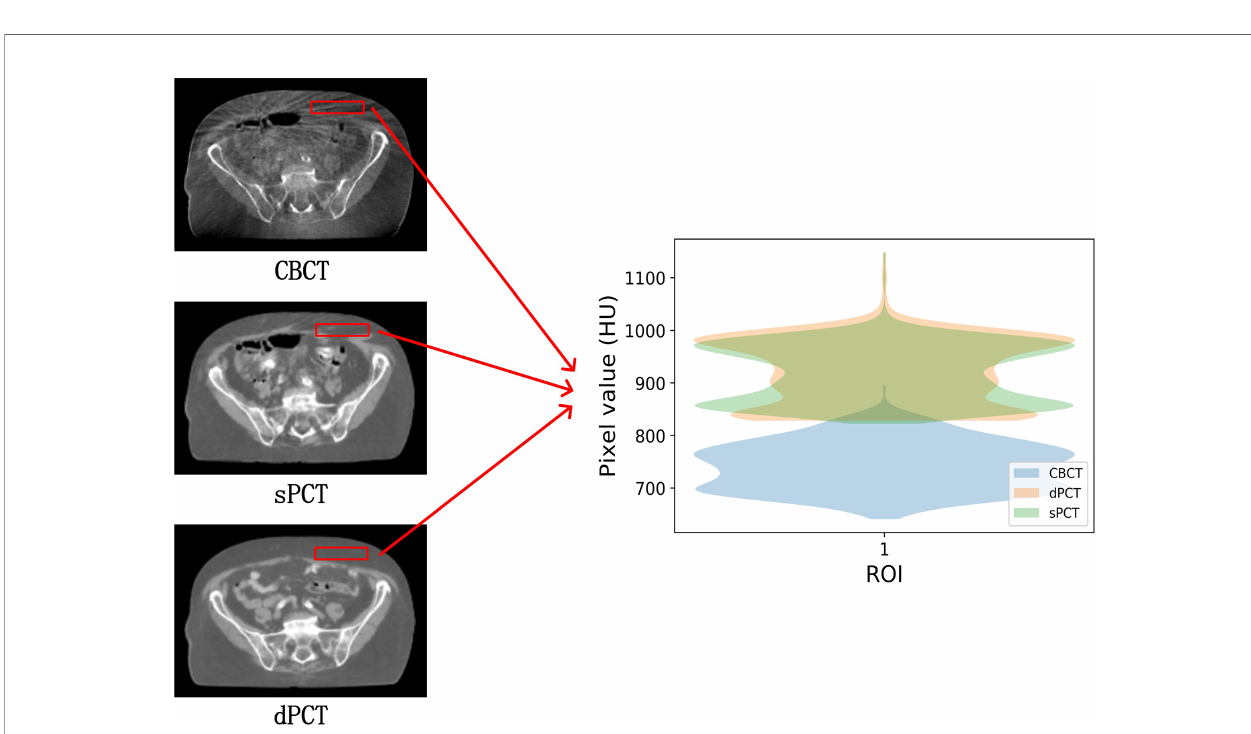
FIGURE 6 | Comparison of ROI ’ s CT number distribution. The selected ROI is 70 × 20 pixels. The right part of the fi gure is the difference mapping of the CT number distribution between CBCT and dPCT, as well as sPCT and dPCT,